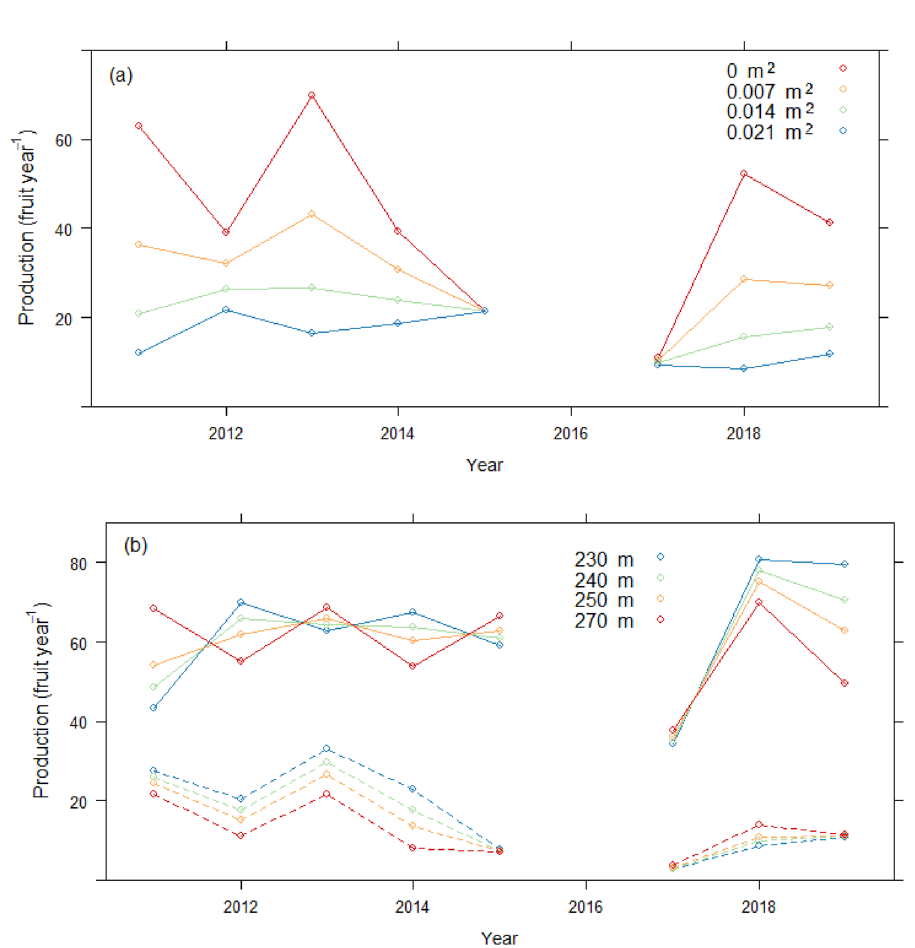
Figure 5. Model 3a marginal mean values of annual fruit production of small trees (DBH< 100 cm): by four values of ( a ) basal area growth (m 2 year −1 ), and ( b ) elevation (m). Solid lines = Cachoeira, dashed lines =